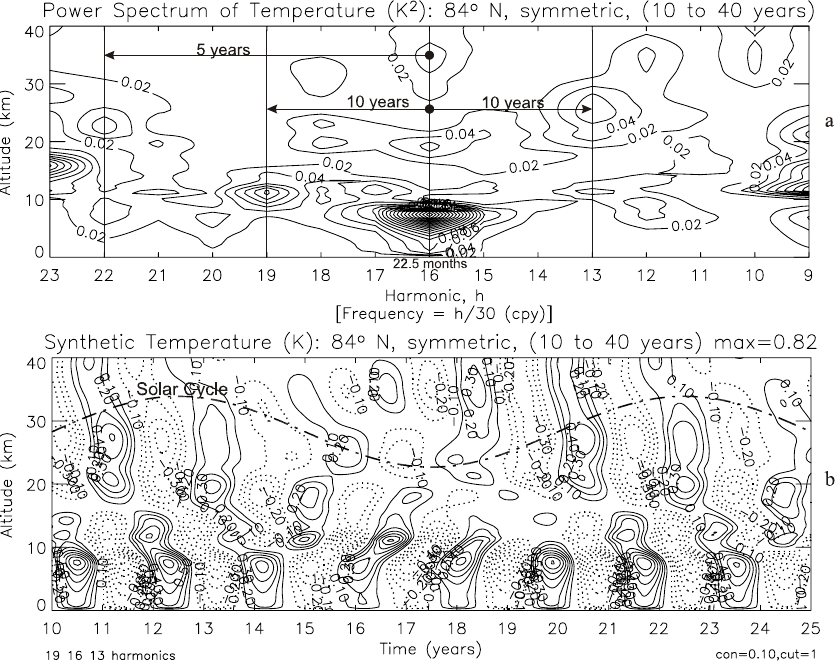
Fig. 5. Similar to Fig. 4 but for the temperature variations of the QBO at 84 ◦ latitude (Gaussian point). (a) As shown, a QBO temperature signature is generated in the troposphere, and the harmonic for the dominant amplitude at h =16 is identical to that for the zonal winds near the equator (Fig. 4a). The side lobes for the 10-year SC occur at h =(16 ± 3), and the 5-year component is visible at h =22 (16+6). (b) The synthesis of the QBO with 10-year SC signatures produces small ( < 1K) temperature variations in the troposphere below